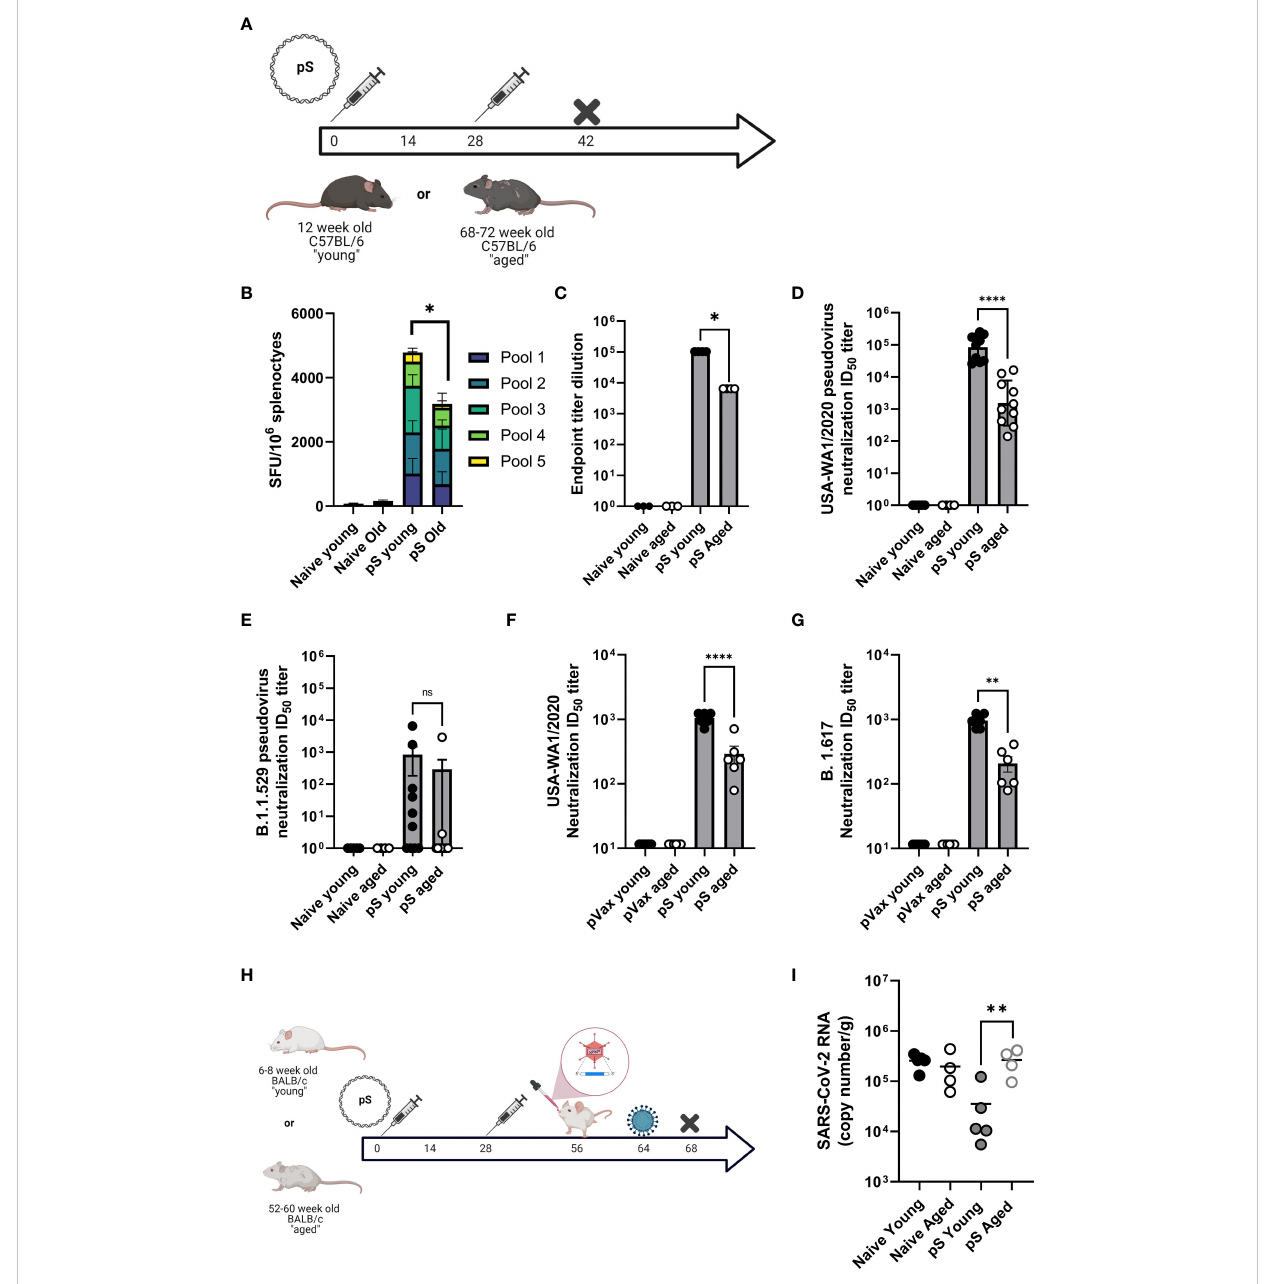
FIGURE 1 Aged mice display altered immune responses to SARS-CoV-2 DNA antigens. (A) 6-8 week-old “ young ” or 68-72 week-old “ aged ” C57BL/6 mice were immunized twice, separated by four weeks with 10ug of synthetic DNA plasmid encoding SARS-CoV-2 spike glycoprotein containing the D>G mutation at position 614 via electroporation and immune responses were assessed at day 14 post-2nd immunization. (B) IFN g spot-forming units (SFU) in splenocytes as measured by ELISpot assay. SARS-CoV-2 parental spike RBD-speci fi c endpoint titers in serum (C) . Serum pseudovirus neutralization against parental (USA- WA1/2020) (D) and Omicron VOC (B.1.1.529/BA.1) spike-pseudotyped viruses (E) . Serum live virus neutralization against parental (USA-WA1/2020) (F) and Delta VOC (B.1.617) spike-pseudotyped viruses (G) . (H) 6-8 week-old “ young ” or 52-60 week-old “ aged ” BALB/c mice were immunized as in A, rested, transduced intranasally with a human ACE2-expressing modi fi ed AAV vector, and challenged intranasally with 1x105 PFU of parental SARS-CoV-2 (VIDO-01). Viral load was quanti fi ed in the lungs at day 4 post-challenge by qPCR (I) . Bars represent the mean, symbols represent the mean of duplicate assay per animal, and error bars represent the SEM. Data are representative of two (A – G) or one independent experiment (H, I) with N= 5-10 mice per group. ns, not signi fi cant. *P<0.05, **P<0.01, and ****P<0.0001 by Kruskal-Wallis